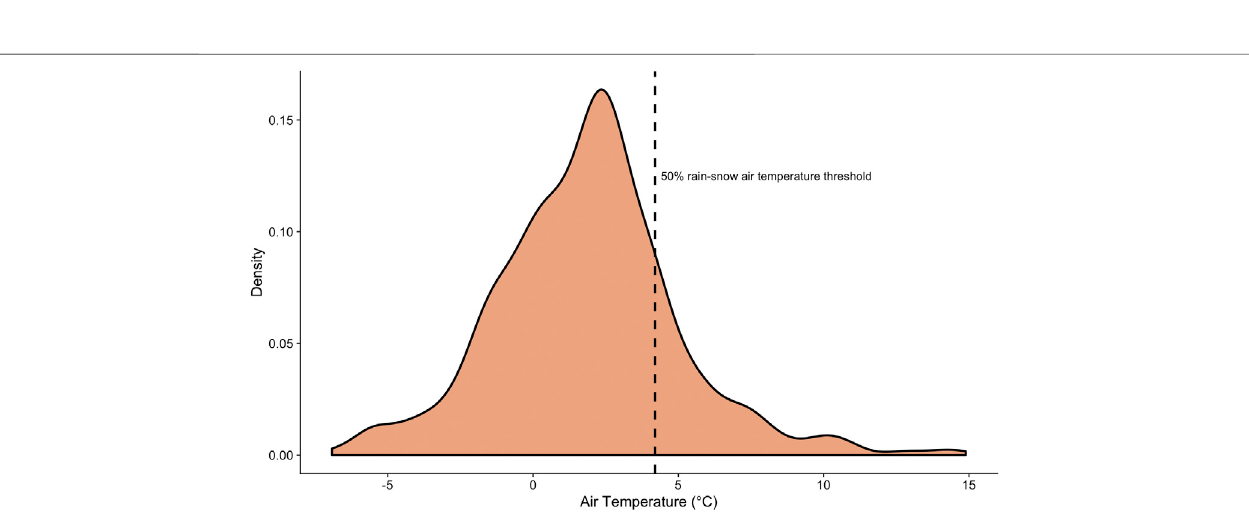
Frontiers in Earth Science |